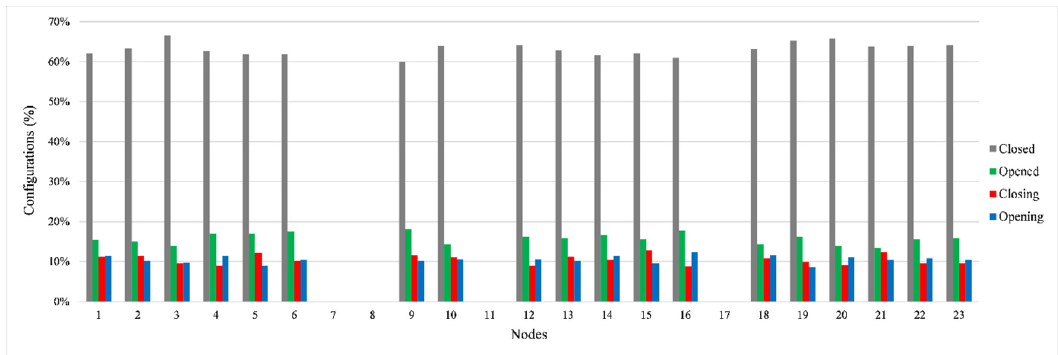
Figure 6. Uniformity distribution of the random number generator (500 hydrant configurations).